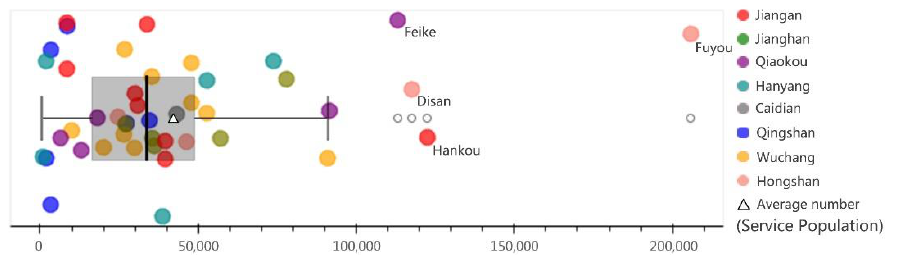
Figure 6. Service population of the fever clinics (summary unit: district) (note: a random Y-value is set for each point to avoid overlapping of points).